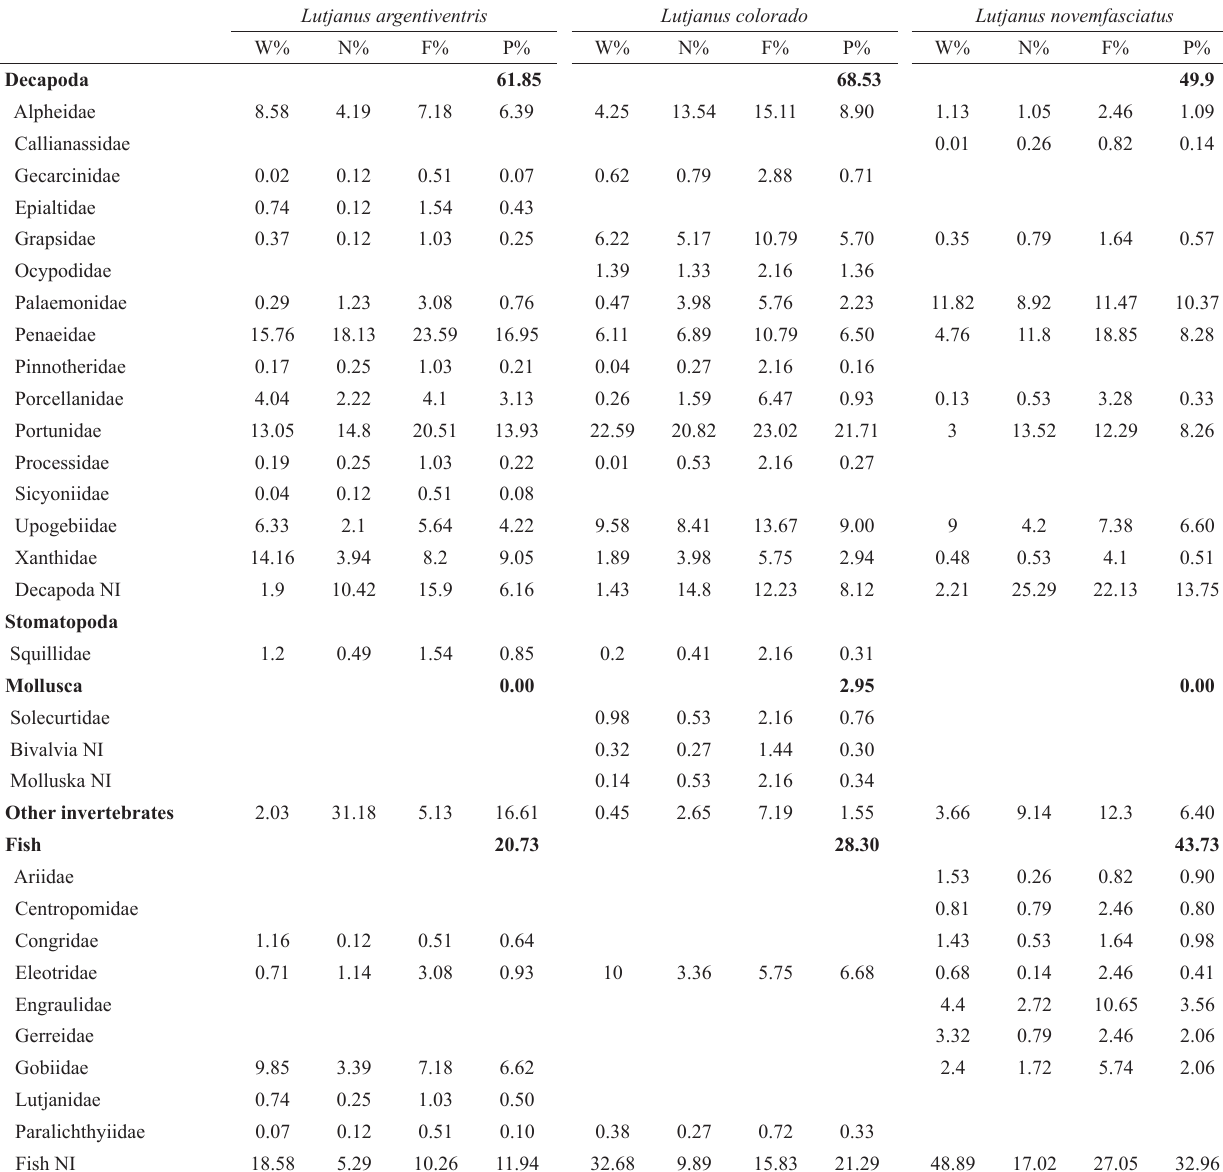
Tab. 1. Diet composition of three species of snappers in Barra de Navidad lagoon. W%: percentage weight; N%: